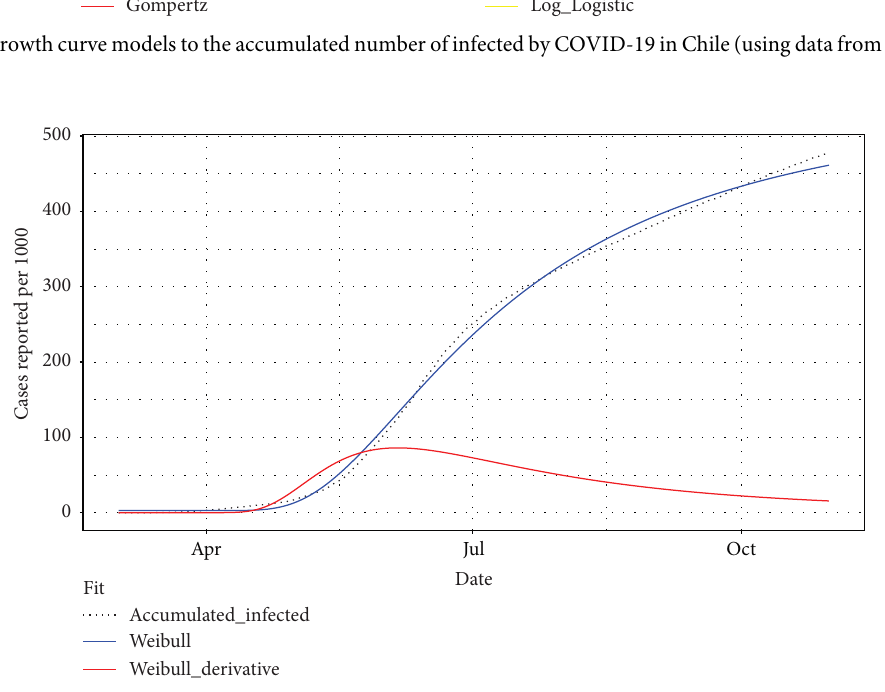
Figure 9: Fit of the Weibull model to the number of cases accumulated by COVID-19 in Chile (in blue) and ft of the evolution of daily cases (in red), using data from March 2 to October 31,